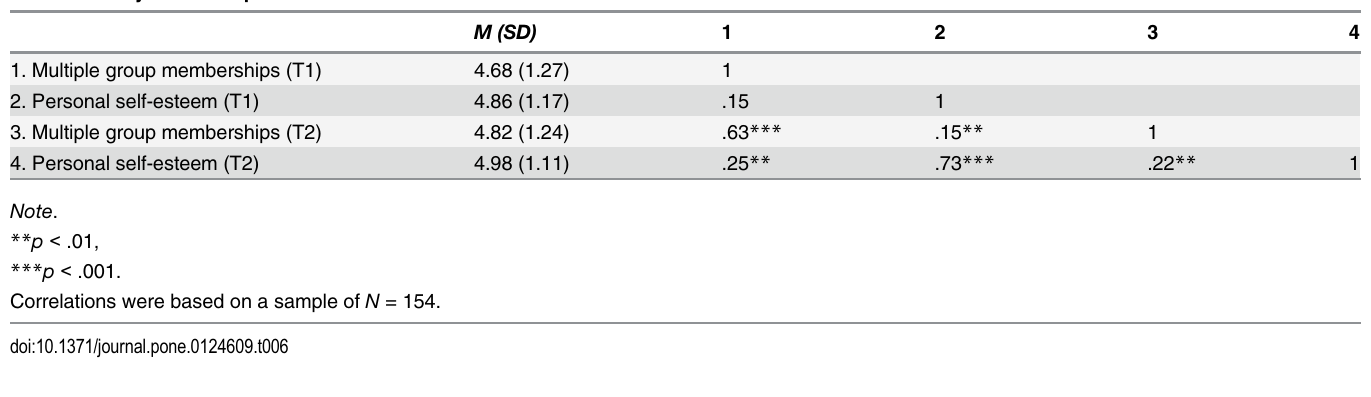
Table 6. Study 3a: Descriptive Statistics and Bivariate Correlations for Students in